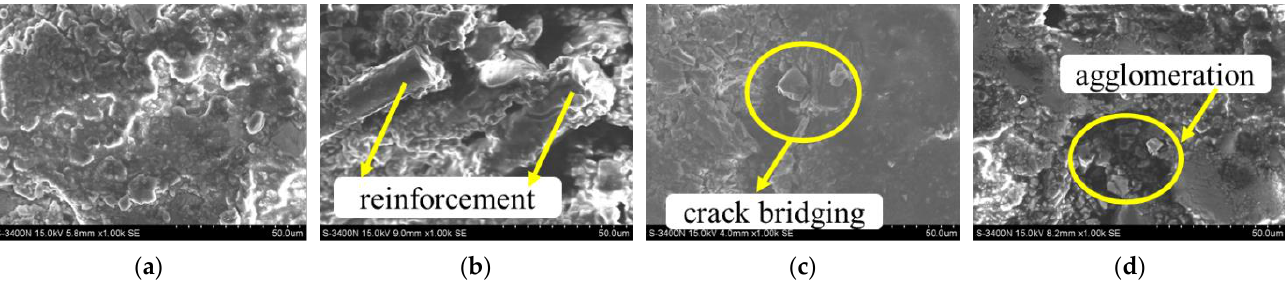
Figure 15. Microstructure of fiber in CRAM: ( a ) process A; ( b ) process B; ( c ) process C; ( d ) process